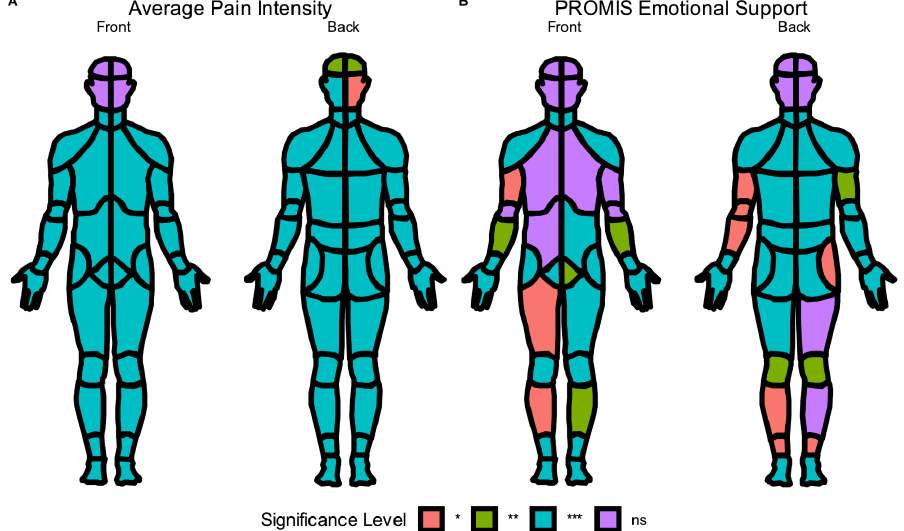
Fig 6. (A) Logistic regression results indicating which locations on the CBM were significantly predicted by the average pain intensity score. Significance levels were stratified and broken up into � p < 0.05, �� p < 0.01,